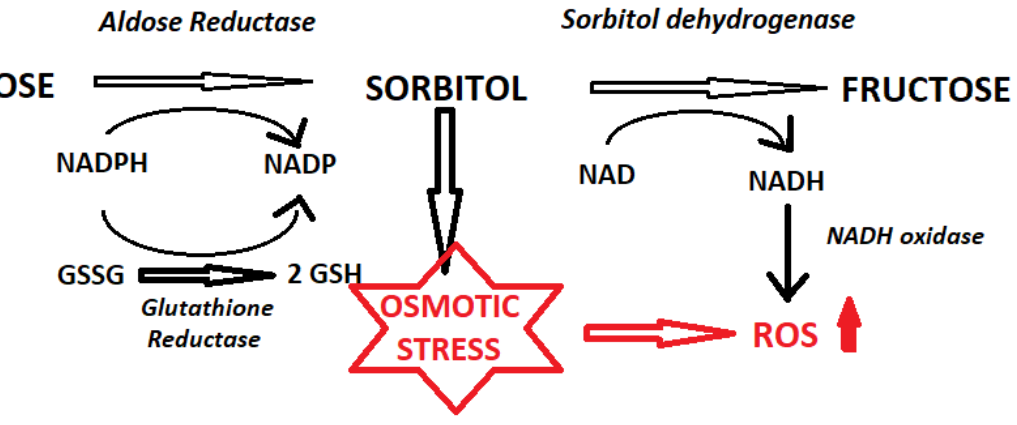
Figure 2. Polyol pathway of glucose metabolism and its effect on ROS.